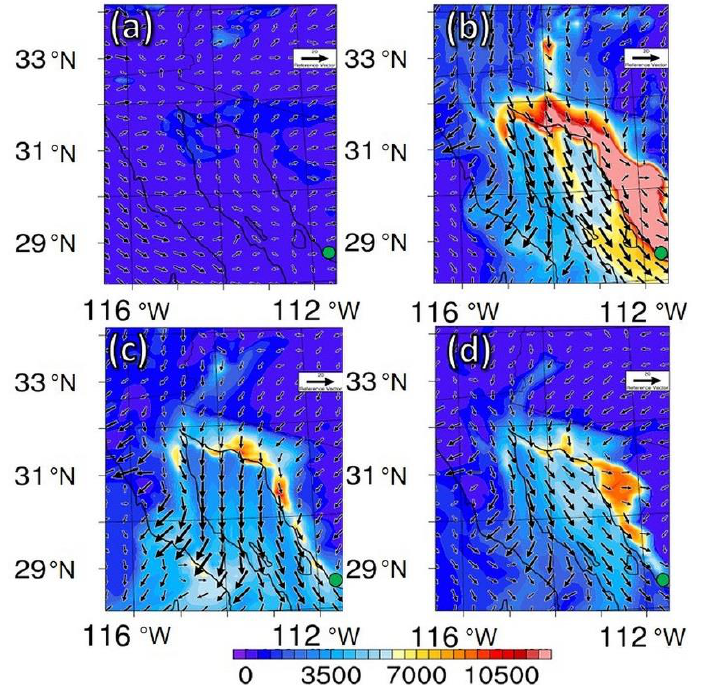
Figure 7. Dust concentration in the lowest layer of the atmosphere ( µ g / m 3 ) and wind vectors with a magnitude reference of 20 m / s in domain 1. ( a ) 00:00 UTC on October 21, ( b ) 00:00 UTC on October 22, ( c ) 00:00 UTC on October 23 and ( d ) 00:00 UTC on October 24. Guaymas is represented by a green point.